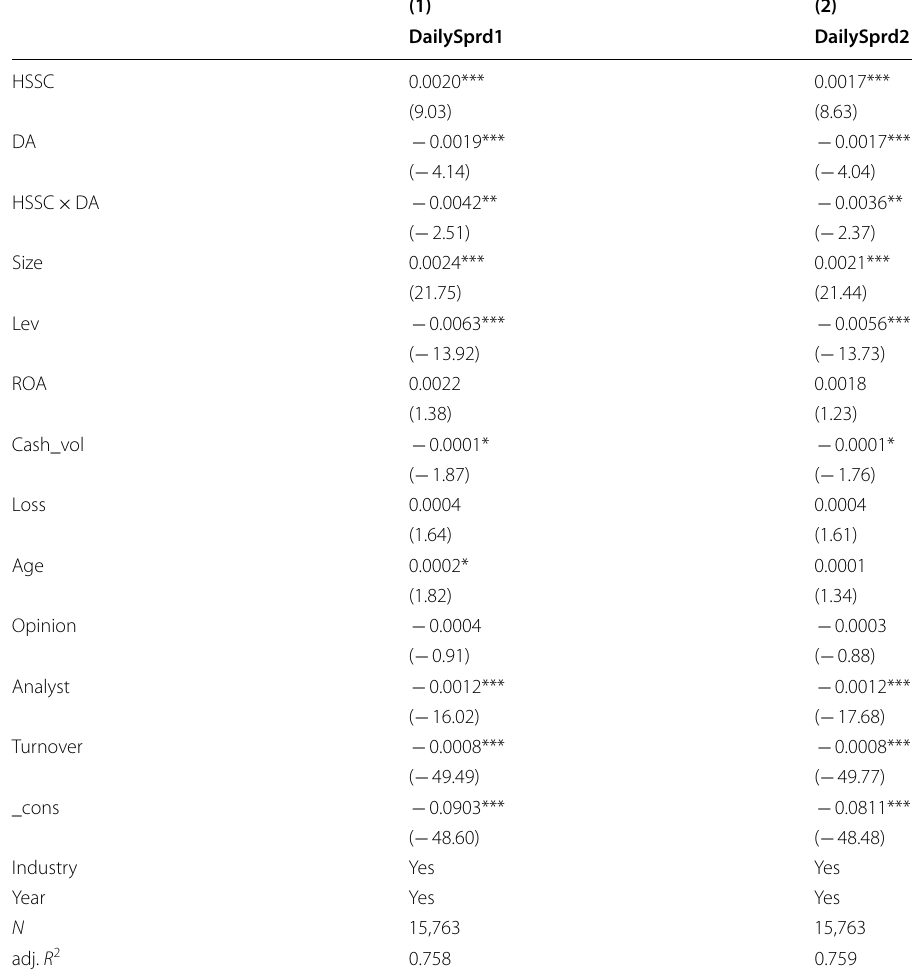
Table 4 Stock connect and market efficiency: the role of corporate